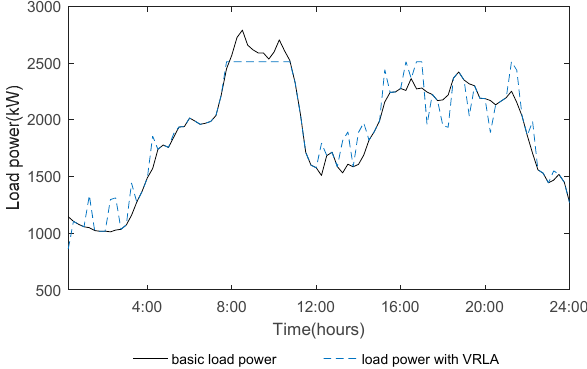
Figure 6. User load power with VRLA (Peak